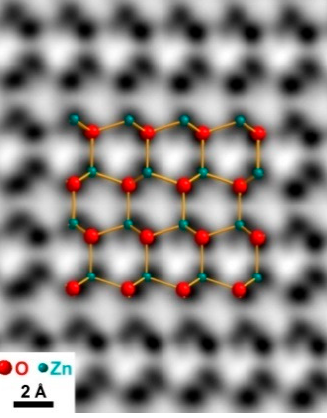
Figure 9. STEM image of ZnO NW with annular bright field (ABF).